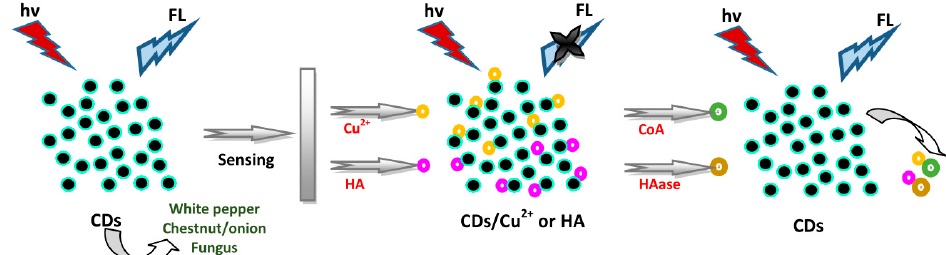
Figure 8. Illustration of plant part-derived CDs for detecting enzymes. The “turn-on” effect on emission intensity was exhibited after adding CoA and HAase to CD/Cu 2+ and CD/HA systems, respectively. Abbreviations: CoA, coenzyme A; HAase, hyaluronidase; HA, hyaluronic acid.